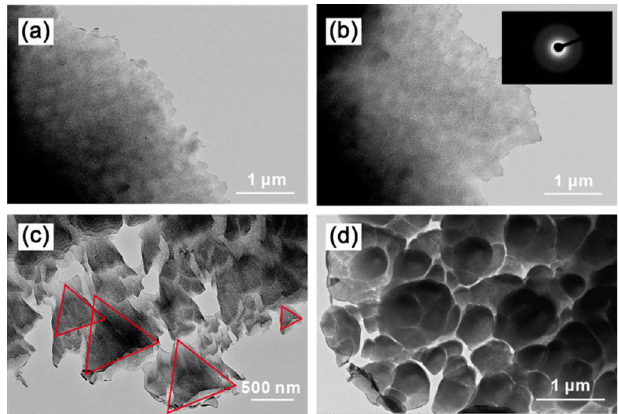
Figure 12. Opal observed by TEM. ( a ) Silica spheres in columns ( d = 210–240 nm) from Opal-05; ( b ) Silica spheres in the matrix ( d = 230–260 nm) from Opal-05; ( c ) The silica particles in columns from Opal-06 are arranged in pyramids, the width of the cone is about 840–900 nm, and the height is about 780–800 nm; ( d ) Silica spheres in the matrix ( d = 250–580 nm) with a clear boundary from Opal-06, composed of small spheres, the diameters of which can be as small as 50 nm.